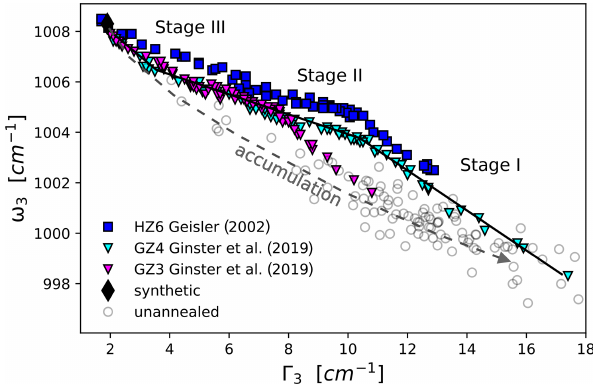
Figure 2. Position-bandwidth ( ω – (cid:48) ) plot of the zircon ν 3 (SiO 4 ) band, showing the stage I–III annealing data of Geisler (2002) and Ginster et al. (2019) compared to the radiation-damage accumula- tion trend (dashed gray arrow), based on the unannealed starting material of our experiment. The black annealing trajectory shows the difference in slope between the stages leading up to the values of synthetic